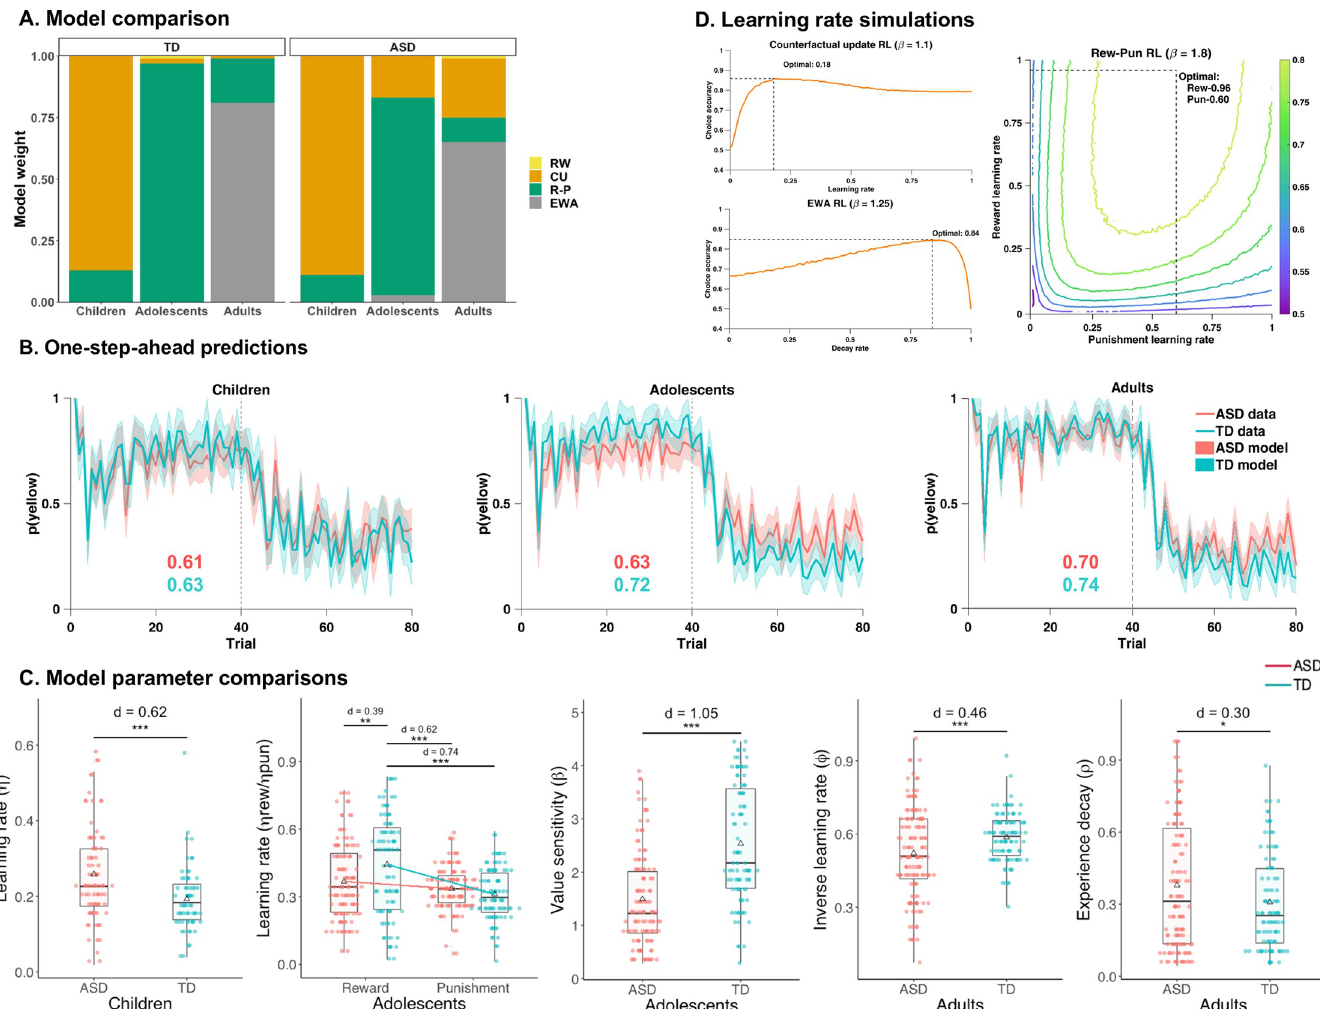
Fig 3. Model comparisons, validations, and parameters. (A) Evidence (model weights) for models within each diagnostic and age group. Very similar patterns are observed for TD and ASD groups; winning models for children, adolescents, and adults are the CU, R-P, and EWA-DL, respectively. (B) One-step-ahead posterior predictions for each age and diagnostic group according to winning models. Colored lines indicate diagnostic-group-averaged trial-by-trial task behavior; shaded areas indicate 95% HDI of the one-step-ahead simulation using the entire posterior distribution. Compare with actual task data in Fig 2A. Posterior predictive accuracies are also indicated on each plot (ASD: red; TD: blue). (C) Model parameter comparisons. Within each winning model and thus age group, parameter estimates were compared between diagnostic groups: (1) ASD children showed a significantly higher learning rate ( η ) than TD children, in which simulations showed the optimal learning rate to be 0.18; (2) ASD adolescents showed a significantly lower reward learning rate than TD adolescents, but no difference between punishment learning rates was observed; (3) ASD adults showed significantly lower φ than TD adults, the optimal value was shown to be 0.85 in simulations, and ASD adults also showed significantly greater experience decay ( ρ ) than TD adults, suggesting great perseveration. (D) Learning rate simulations showing optimal learning rates for each model (Counterfactual update, compare to Fig 3C Children; Rew-Pun, compare to Fig 3C Adolescents—Learning rate; EWA, Experience-weighted attraction-dynamic learning rate, compare to Fig 3C Adults—Inverse learning rate). ��� p < .001, �� p < .01, � p < .05; Δ indicates group mean (see S1 Data). ASD, autism spectrum disorder; CU, counterfactual update; d , Cohen’s d model; EWA-DL, experience-weighted attraction–dynamic learning rate model; HDI, highest density interval; R-P, reward- punishment model; Rew-Pun, reward-punishment; RL, reinforcement learning; RW, Rescorla-Wagner; TD, typical